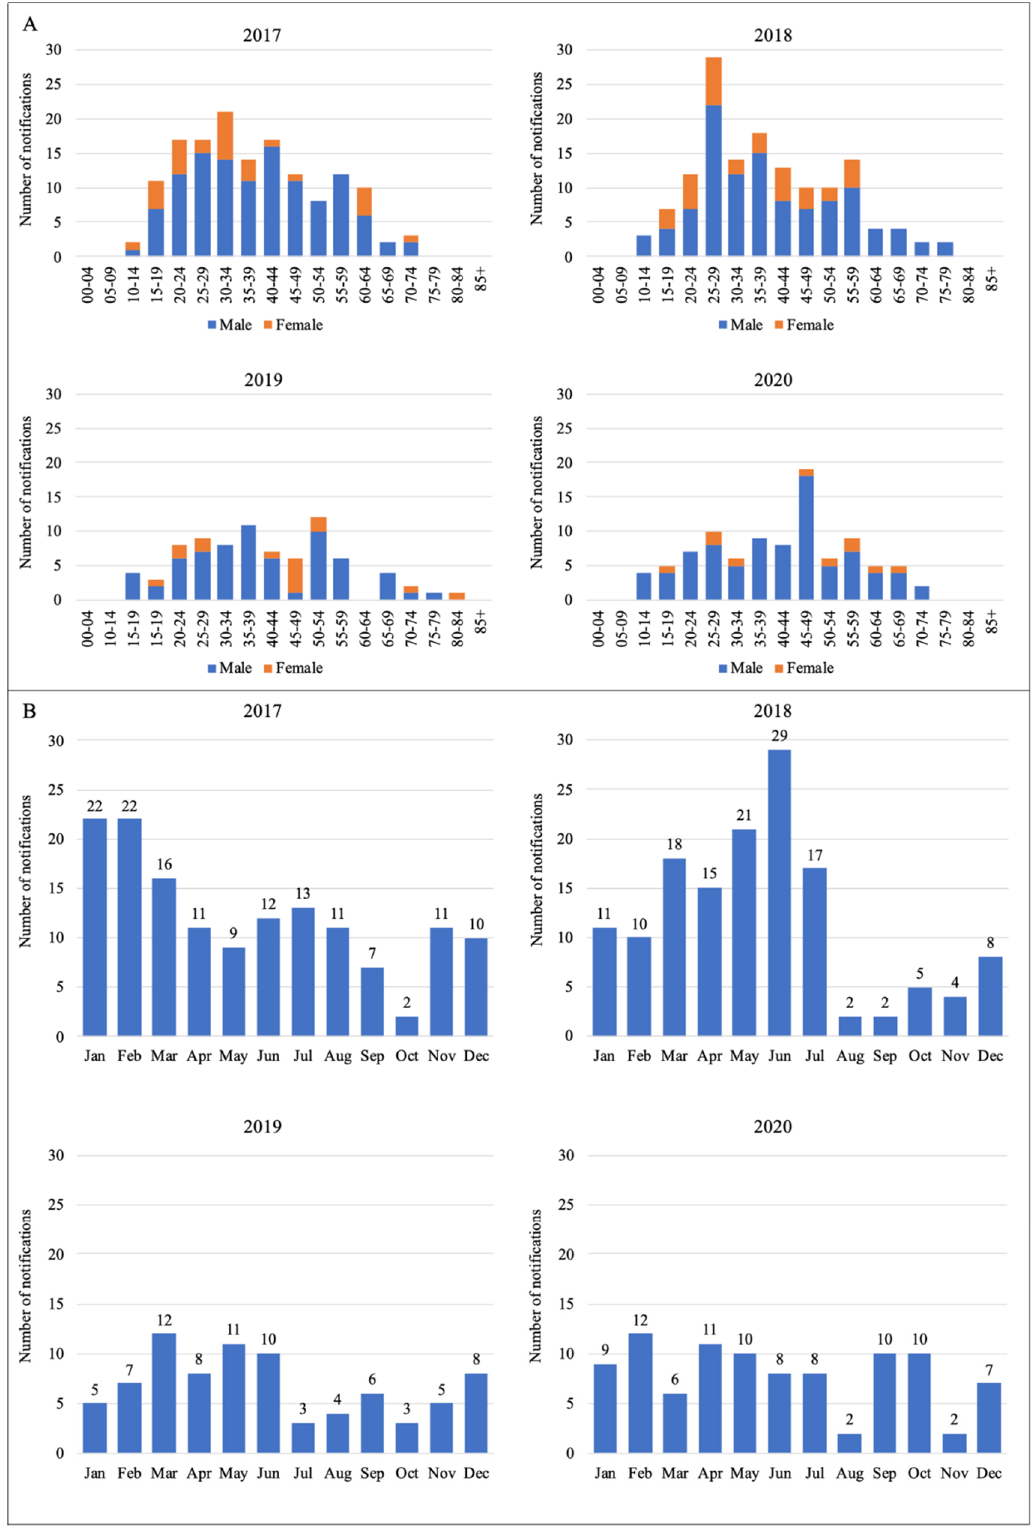
Figure 2. Number of leptospirosis notifications notified to the NNDSS from 2017 to 2020 by: ( A ) age and gender; ( B ) month [17].